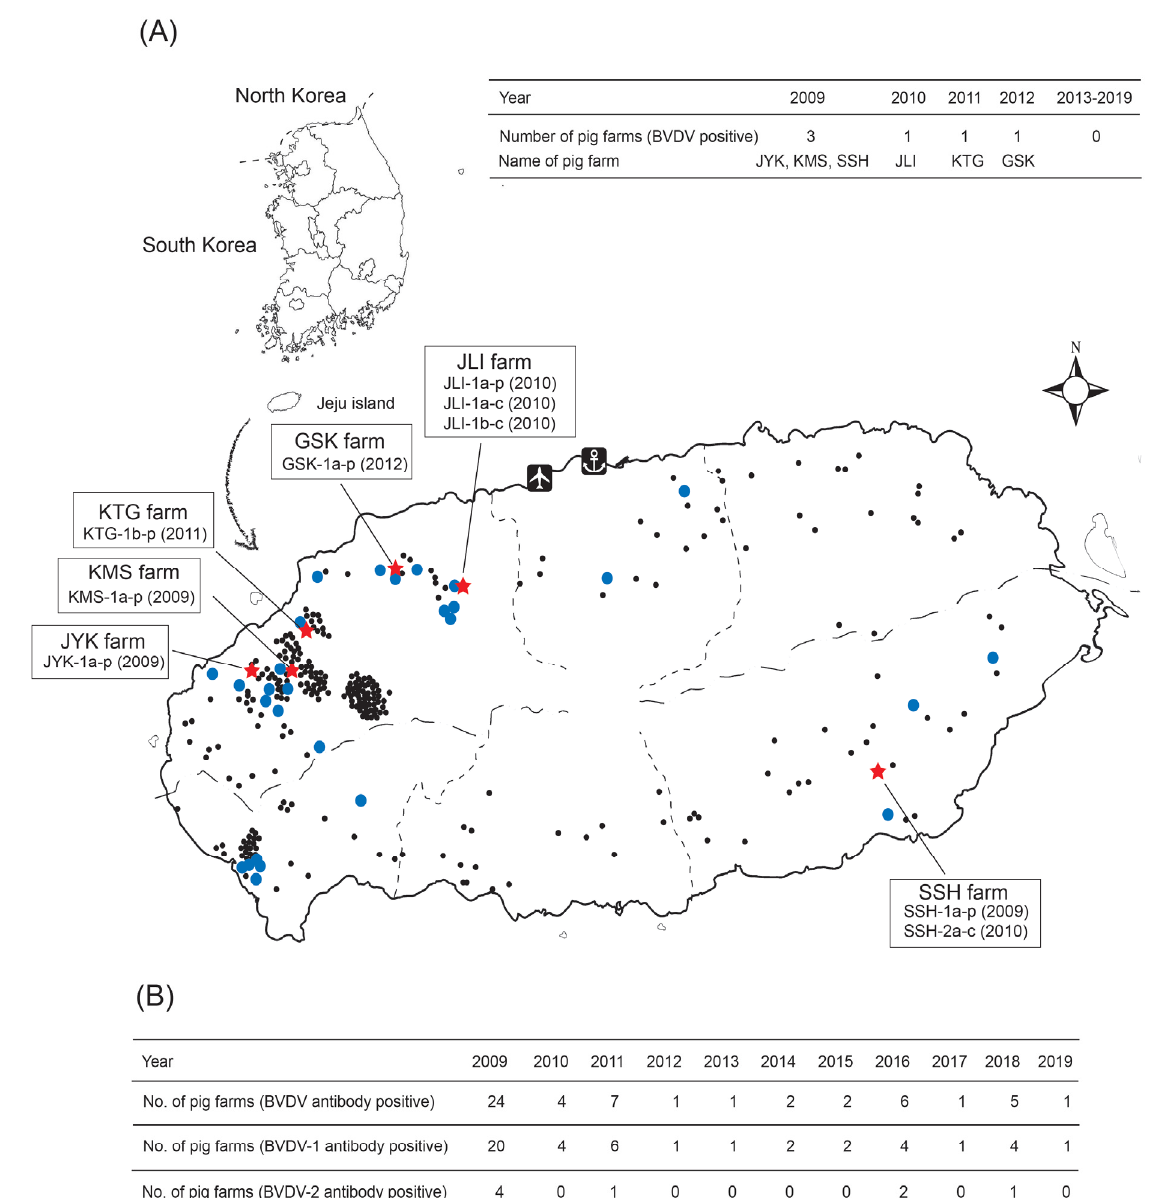
Figure 1. Bovine viral diarrhea virus–positive and BVDV antibody-positive pig farms on Jeju Island, 2009–2019. The locations and three letter designations of BVDV–positive pig farms are shown on the map ( A ). Number of BVDV antibody–positive pig farms ( B ). Pig farms, cow farms, and BVDV–positive pig farms are indicated by black dots, blue dots, and red stars, respectively.